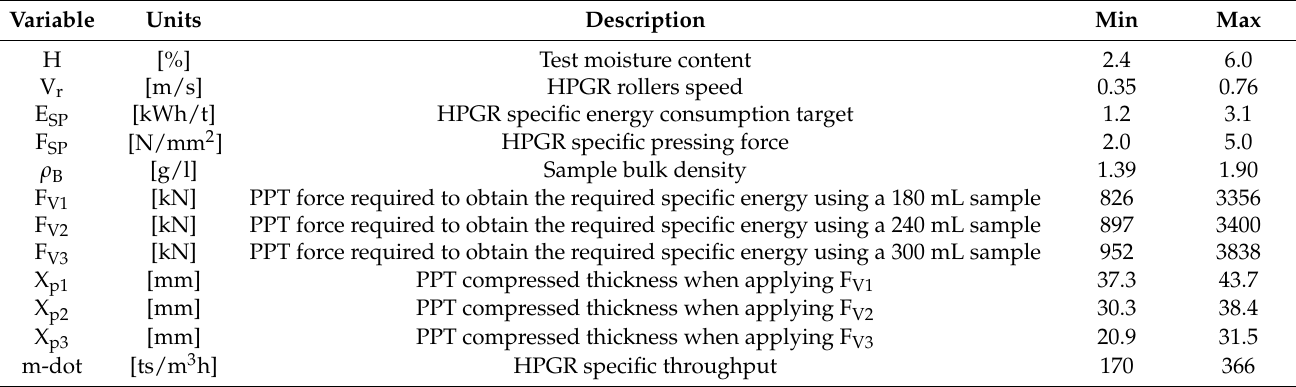
Table 3. Variables used for